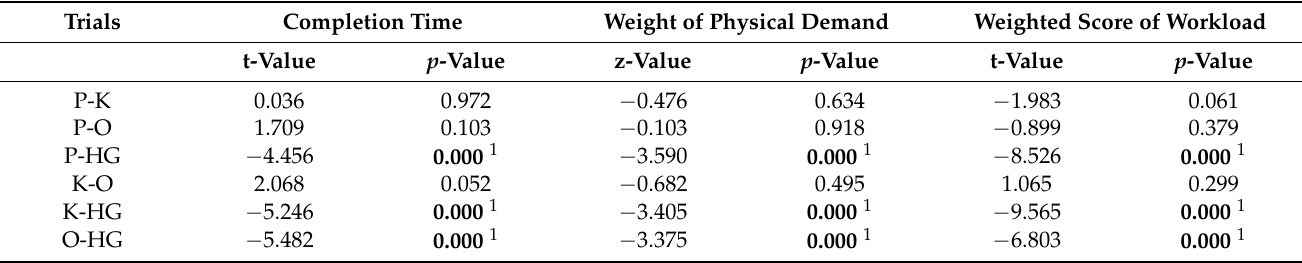
Table 3. The results of post hoc comparisons of completion time, the weight of physical demand, and the weighted score of workload between trials.